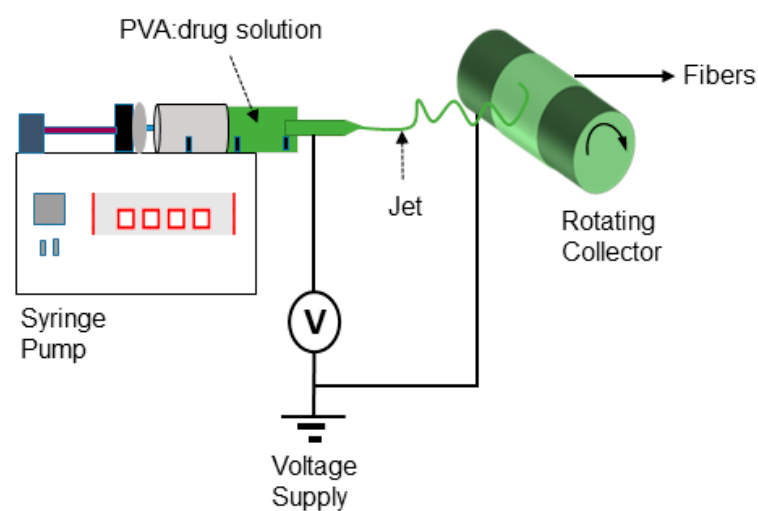
Figure 10. Schematic representation of the electrospinning setup used to fabricate nanofibers.